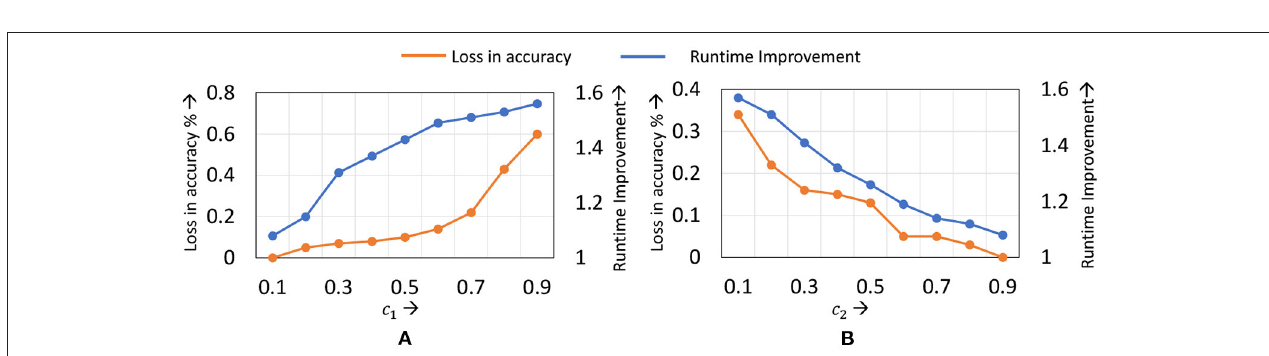
FIGURE 10 | Compute efficiency vs. accuracy trade-off obtained by varying (A) c 1 and (B) c 2 in the static learning mode selection algorithm for ResNet18 on the Cifar10 dataset.